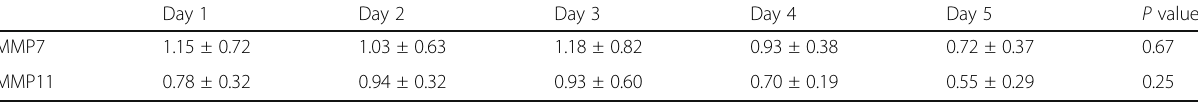
Table 3 Comparison between MMP7&MMP11 mean through different days of menses